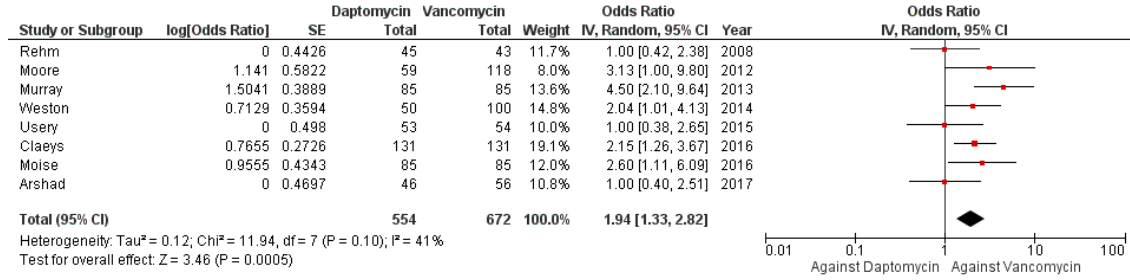
Figure 3. Forest plot depicting the odds ratio of clinical failure of patients receiving daptomycin vs. vancomycin.